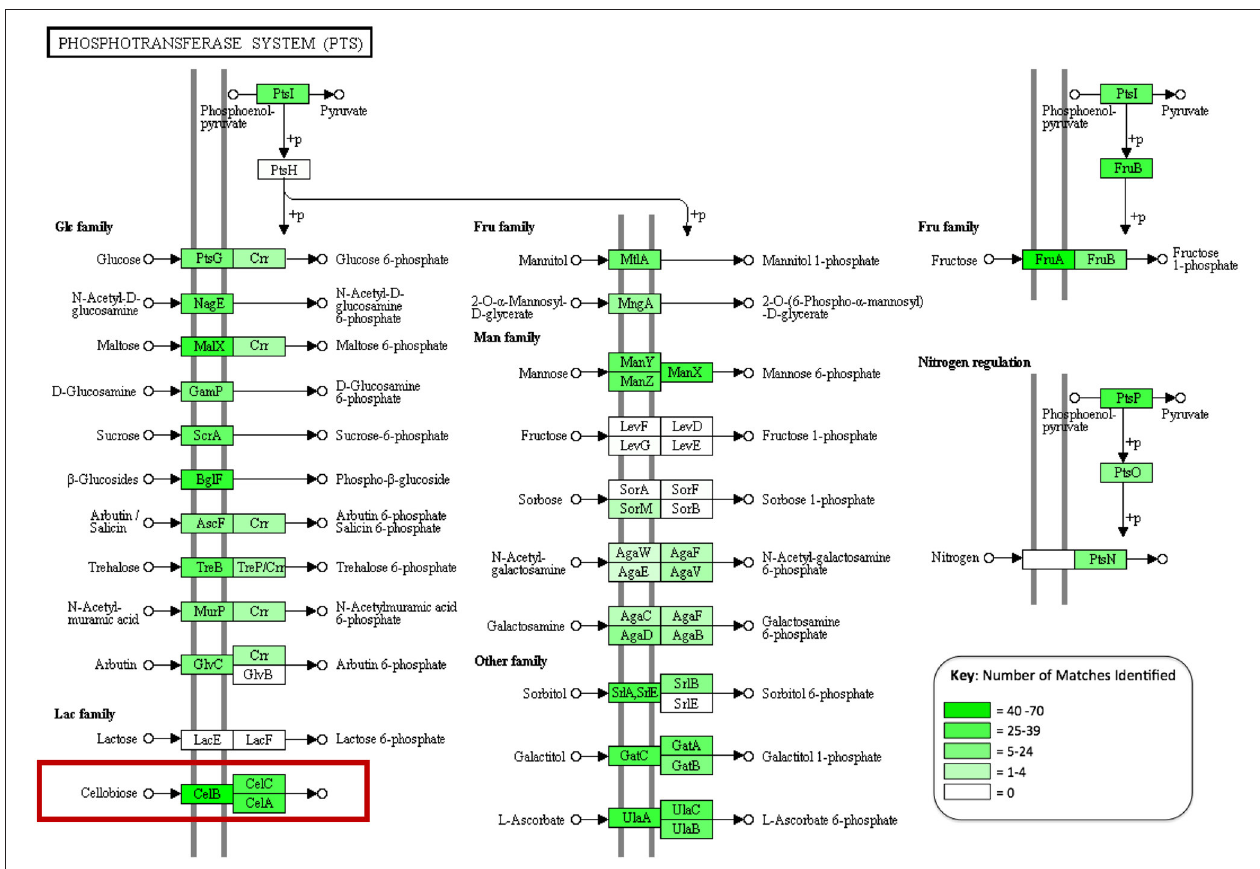
FIGURE 2 | A KEGG diagram showing the phosphotransferase system (PTS), genes identified in the gut metagenome are highlighted in green with color intensity corresponding to abundance observed (created in MEGAN4).